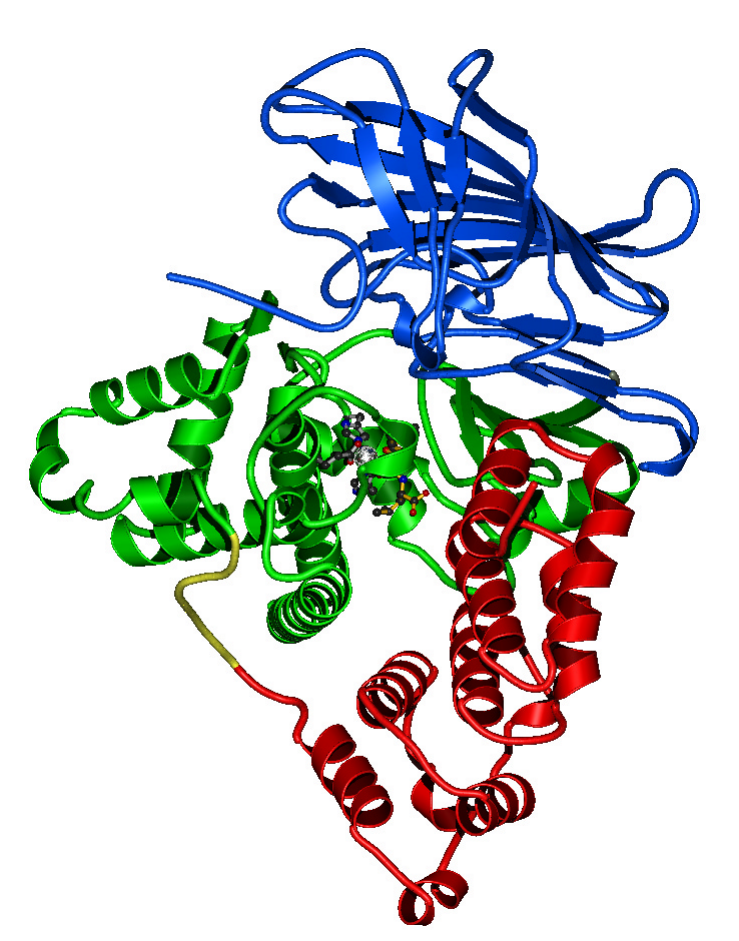
FIGURE 2. Overall structure of LTA 4 hydrolase. Ribbon diagram of the 3D-structure of LTA 4 hydrolase. The N-terminal domain is colored blue, the catalytic domain green, and the C-terminal domain red. A loop (residues 451–460) containing a highly conserved Pro-rich motif and connecting the catalytic and C-terminal domain is shown in yellow. In the central part of the molecule, the catalytic zinc and the three amino acid ligands are shown. The figure was created using MolScript[72] and POV-Ray